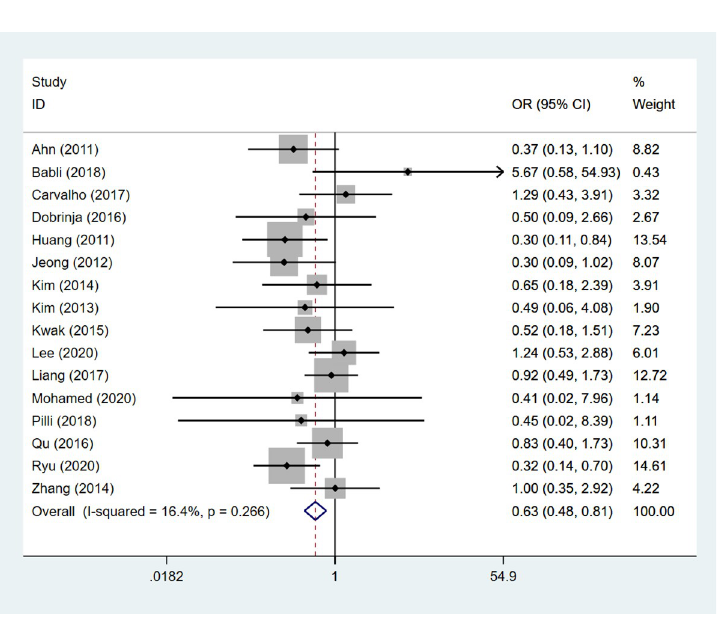
Fig 5. The forest plot of recurrence between HT group and non-HT group.